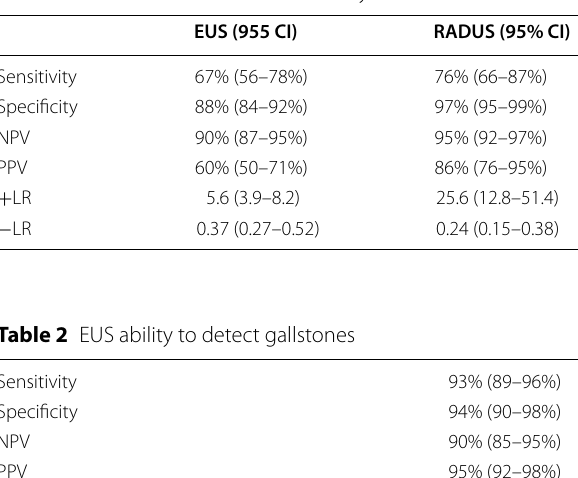
Table 1 EUS vs. RADUS for acute cholecystitis